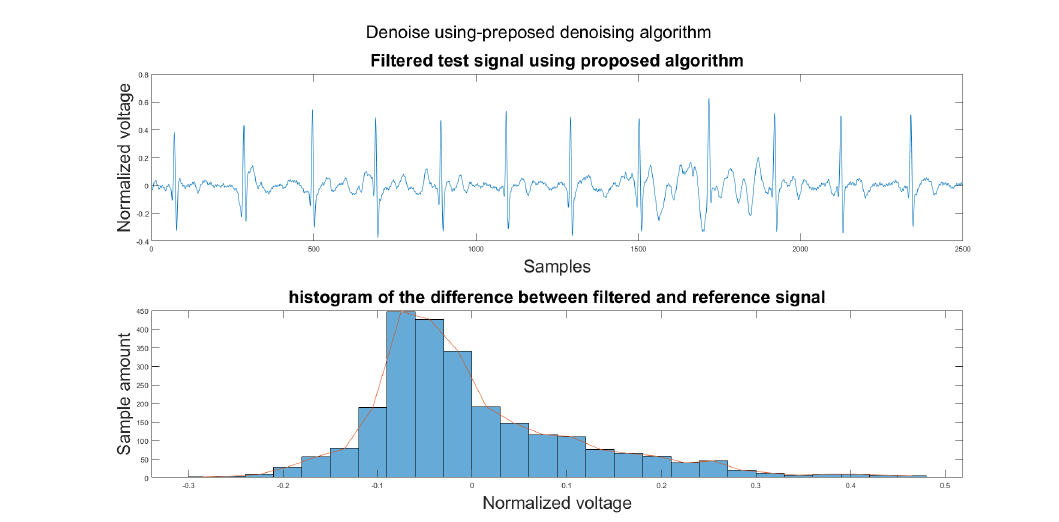
Figure 14. (1) Test signal, (2) histogram of the